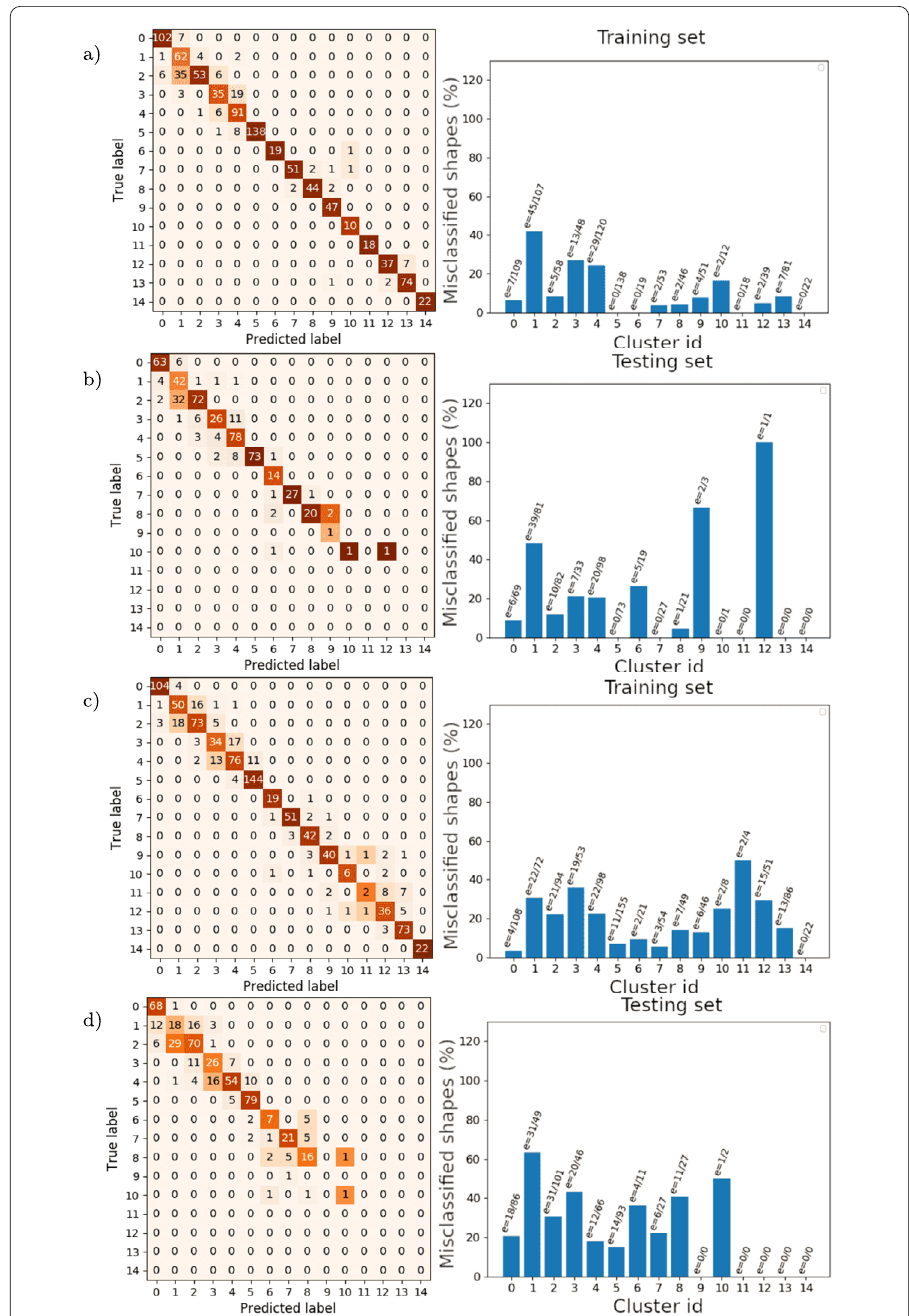
Figure 12 Left column: confusion matrices for the training (rows a , c ) and testing sets (rows b , d ) between Grassmann clustering (true label) and the label predicted by the dense neural network using the signed (rows a , b ) and spherical harmonics distances (rows c , d ). Right: percentage of misclassified shapes in each cluster